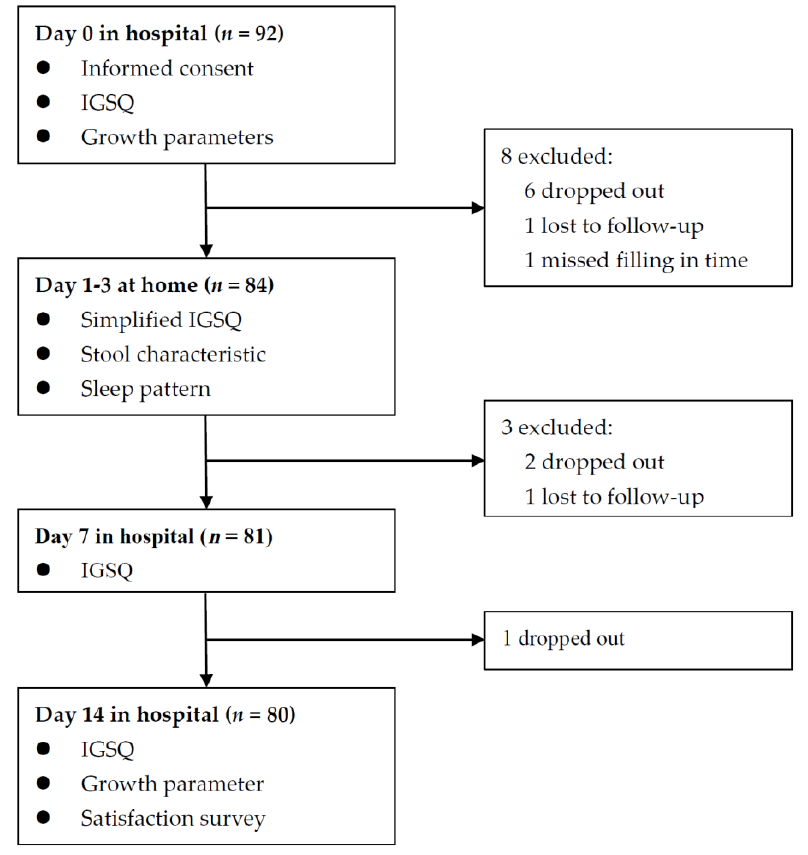
Figure 1. Flow chart of enrolled infants.